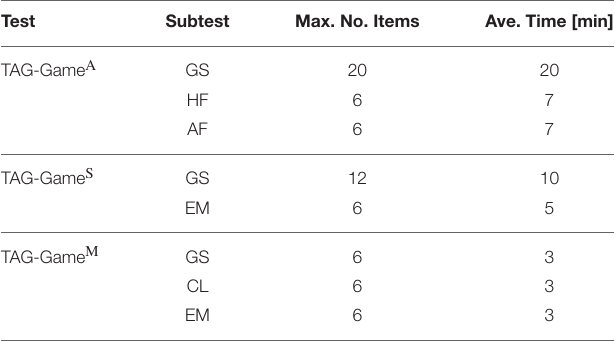
TABLE 2 | The number of items and the average administration time for six subtests of TAG-Games. Test Subtest Max. No. Items Ave. Time [min]